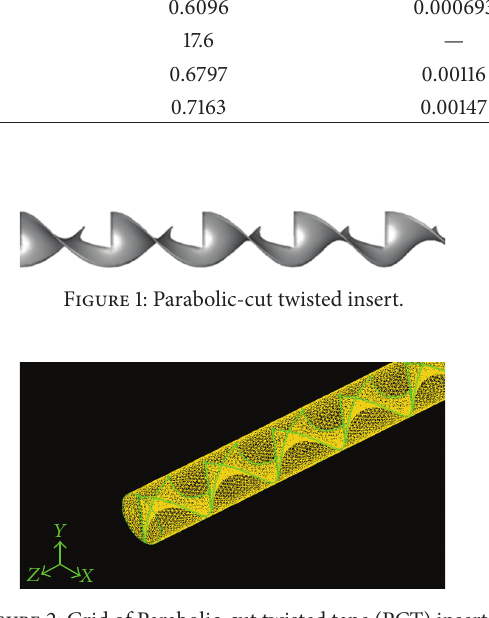
Figure 2: Grid of Parabolic-cut twisted tape (PCT)